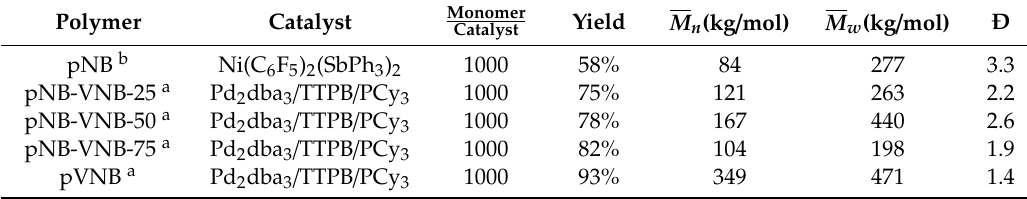
Table 2. Reaction and GPC data for polynorbornene series with increasing exocyclic vinyl group presence. Calibrated using polystyrene standards.